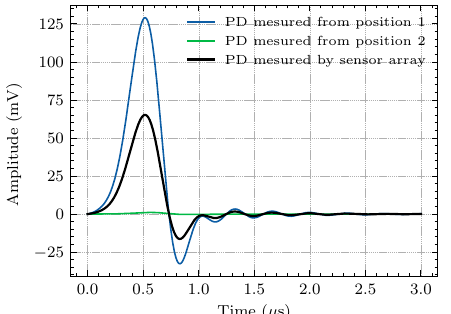
Figure 8. Simulated PD responses of the sensor array and the single sensor at different detection